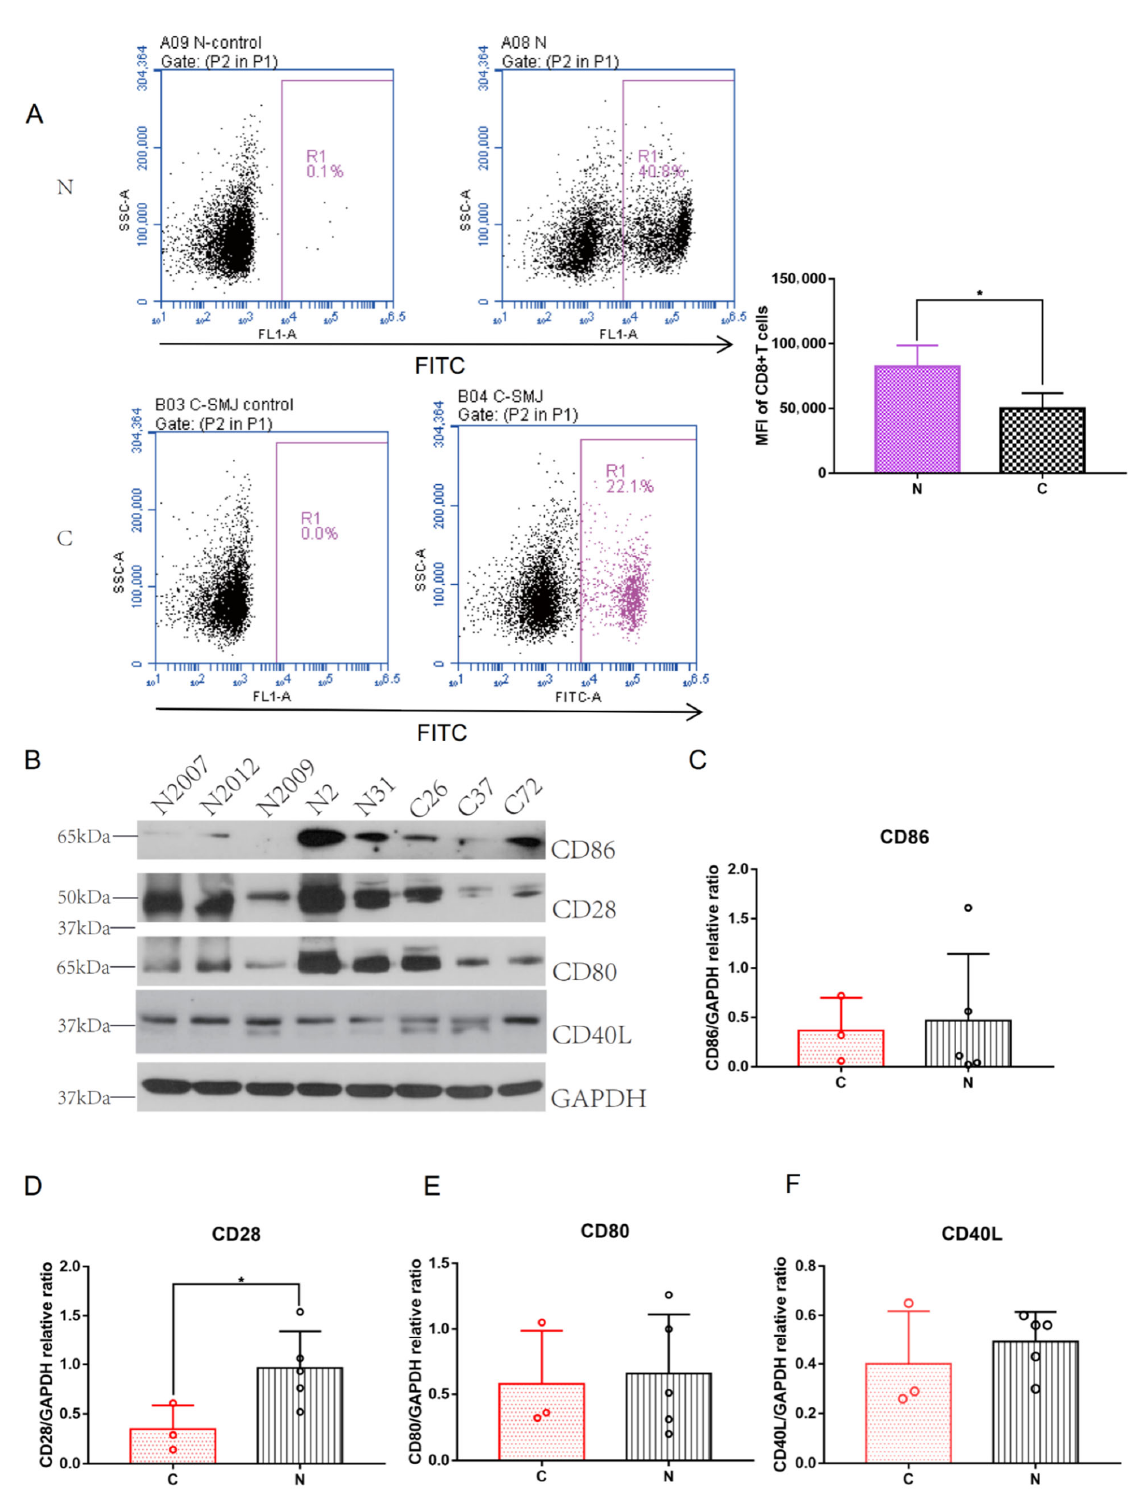
Figure 7. ( A ) CD8 + T cells were assayed by flow cytometric analysis between Groups N and C. MFI, Mean Fluorescence Intensity. * p < 0.05. ( B ) Western blotting expression of CD86, CD28, CD80 and CD40L between Groups N and C. ( C – F ) Quantitative comparison of CD86, CD28, CD80 and CD40L between Groups N and C. * p <